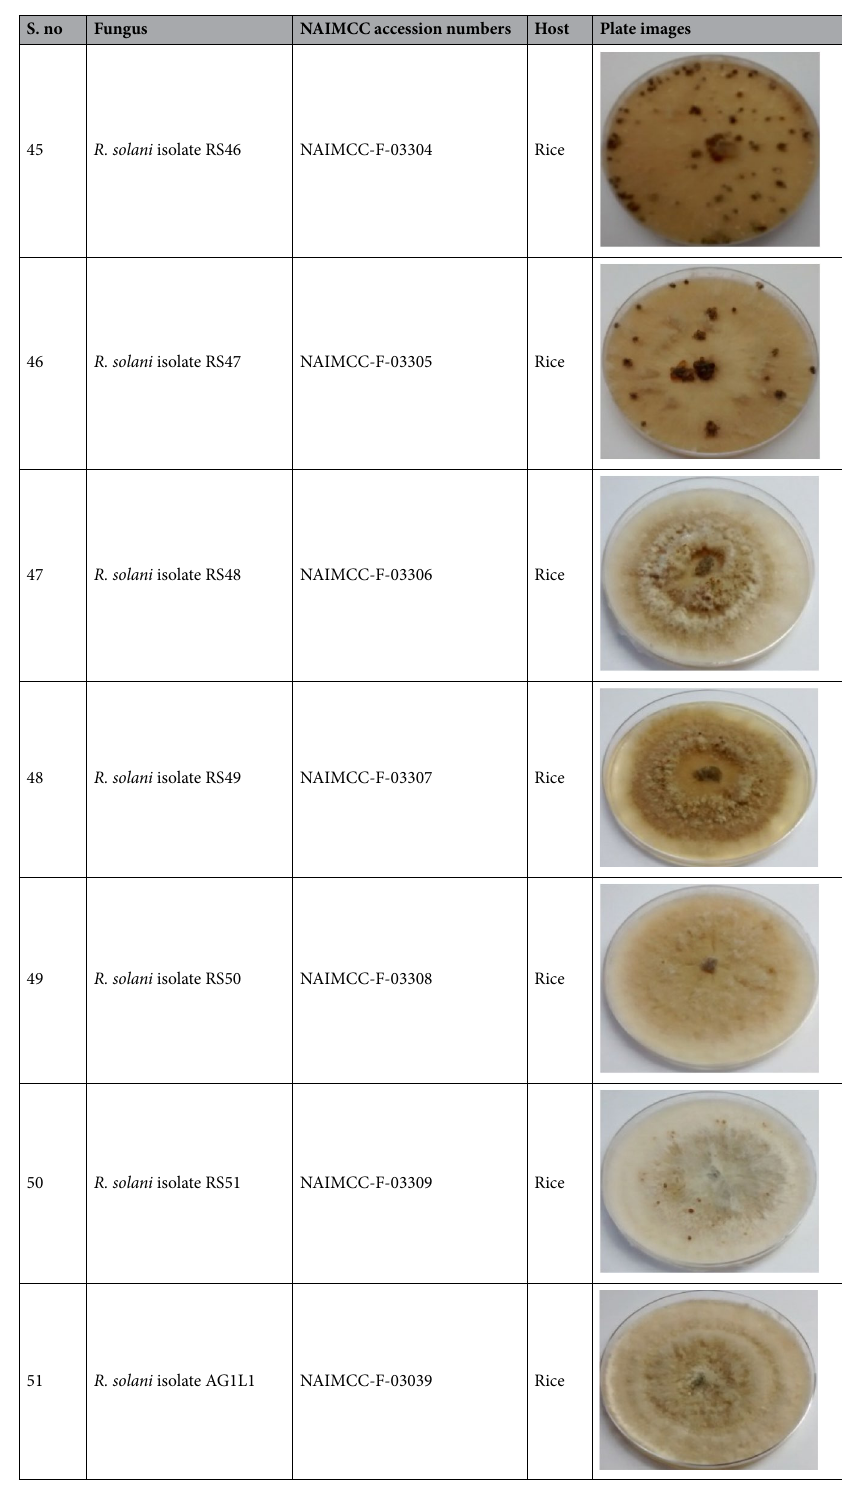
Table 1. Details of all the purified isolates along with the sampling details, morphology of the cultures on PDA and submission details of the